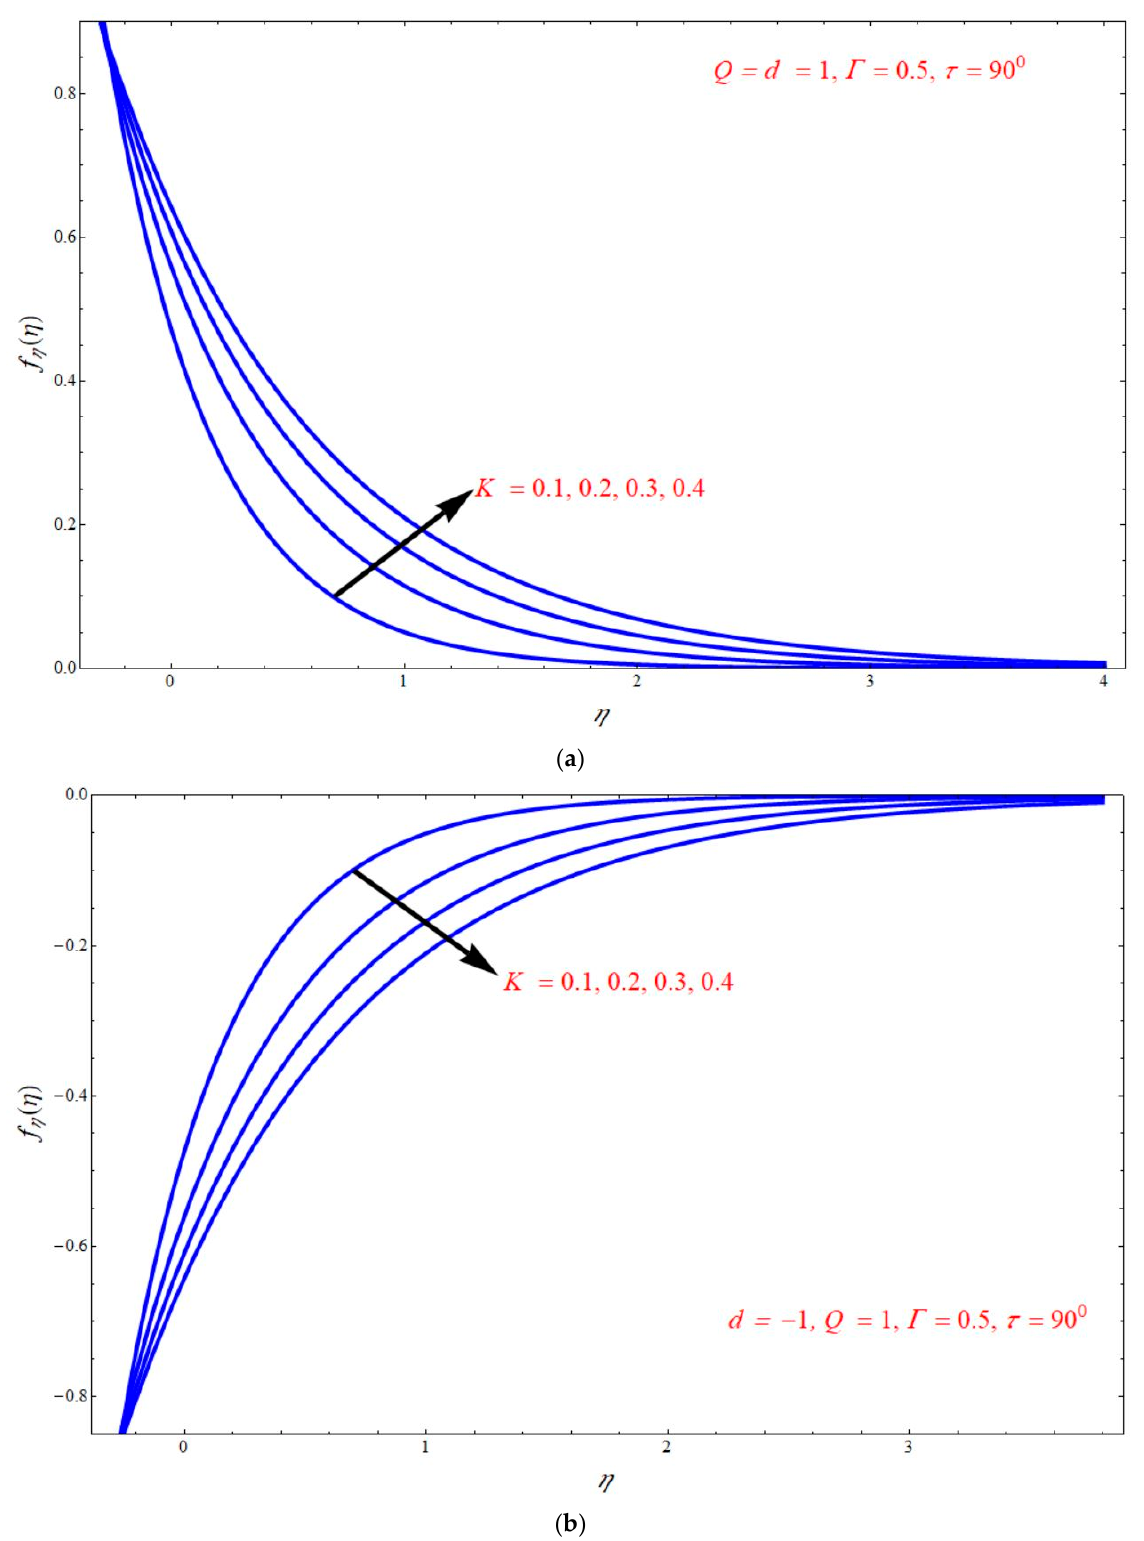
Figure 4. Plots of Figure 4. Plots of f η ( η ) verses η for different choices of k 1 for ( a ) d = 1 and ( b ) d = −